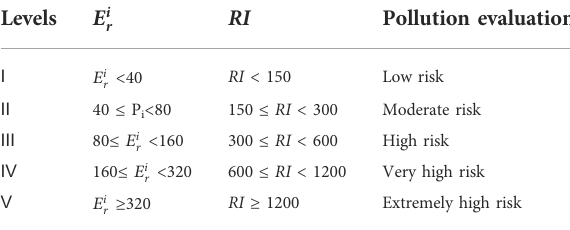
TABLE 4 Hierarchical evaluation standards of potential ecological risks of heavy metals.